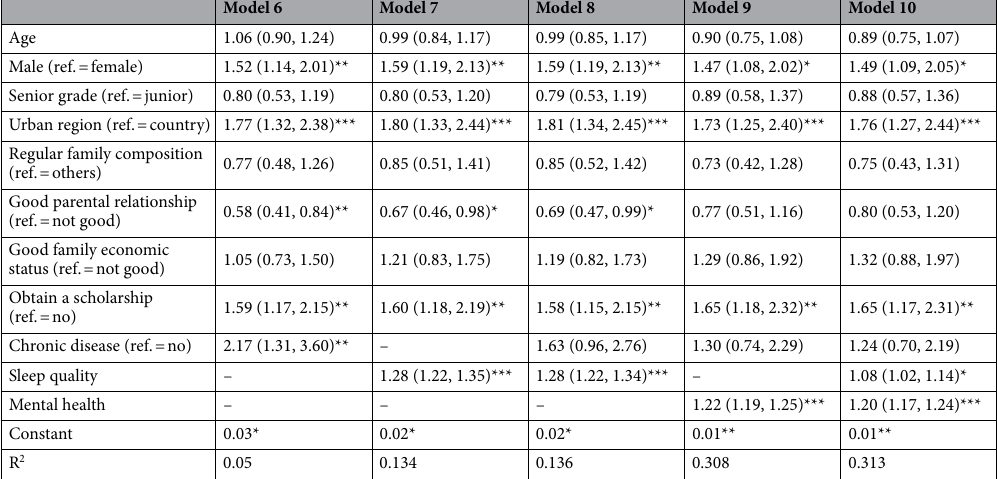
Table 3. Binary logistic regression for the factors associated with past 12-month suicidal ideation (N = 2646). Only ORs and their 95% CIs were presented in the table. *p<0.05; **p<0.01;